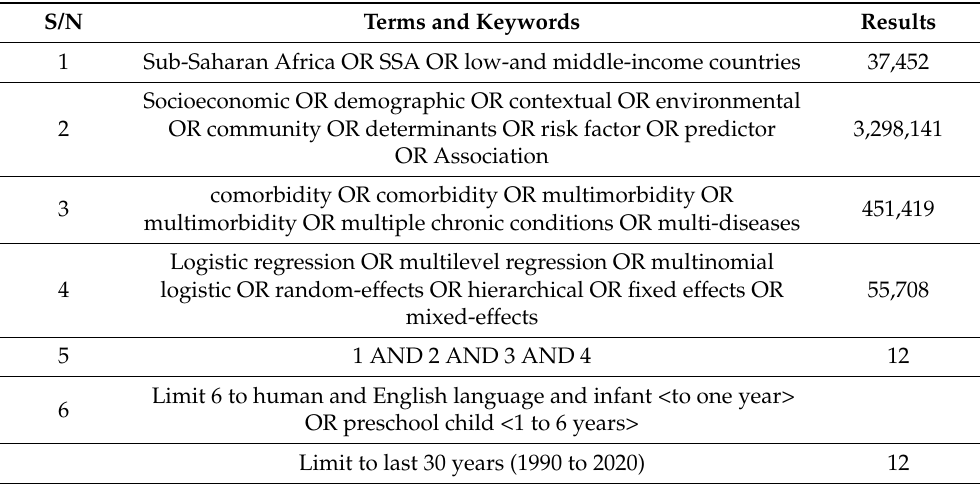
Table 1. Draft Search strategy and terms for MEDLINE